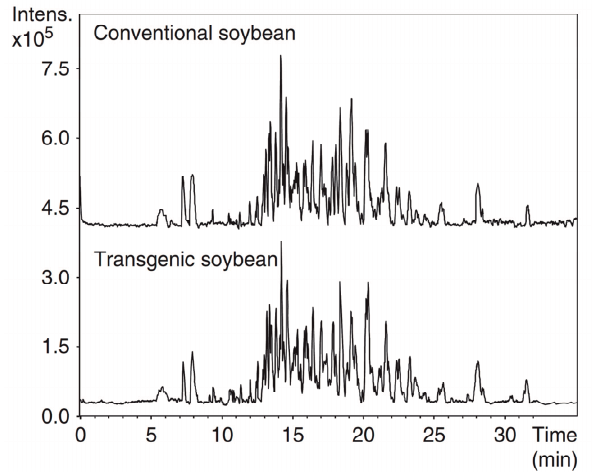
Figure 3. CE-TOF base peak electropherogram of the digested protein extract from conventional and transgenic soybean. Reprinted with permission from